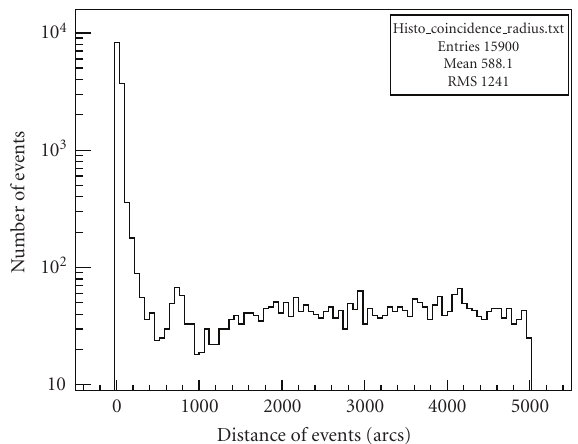
Figure 3: Distribution of angular distances between all event candidate pairs from images collected by cameras k2a and k2b during night 2006-05-28/29. Number of event candidates from single camera is typically of the order of 10 4 -10 5 , which results in a combinatorial background at distances ≥